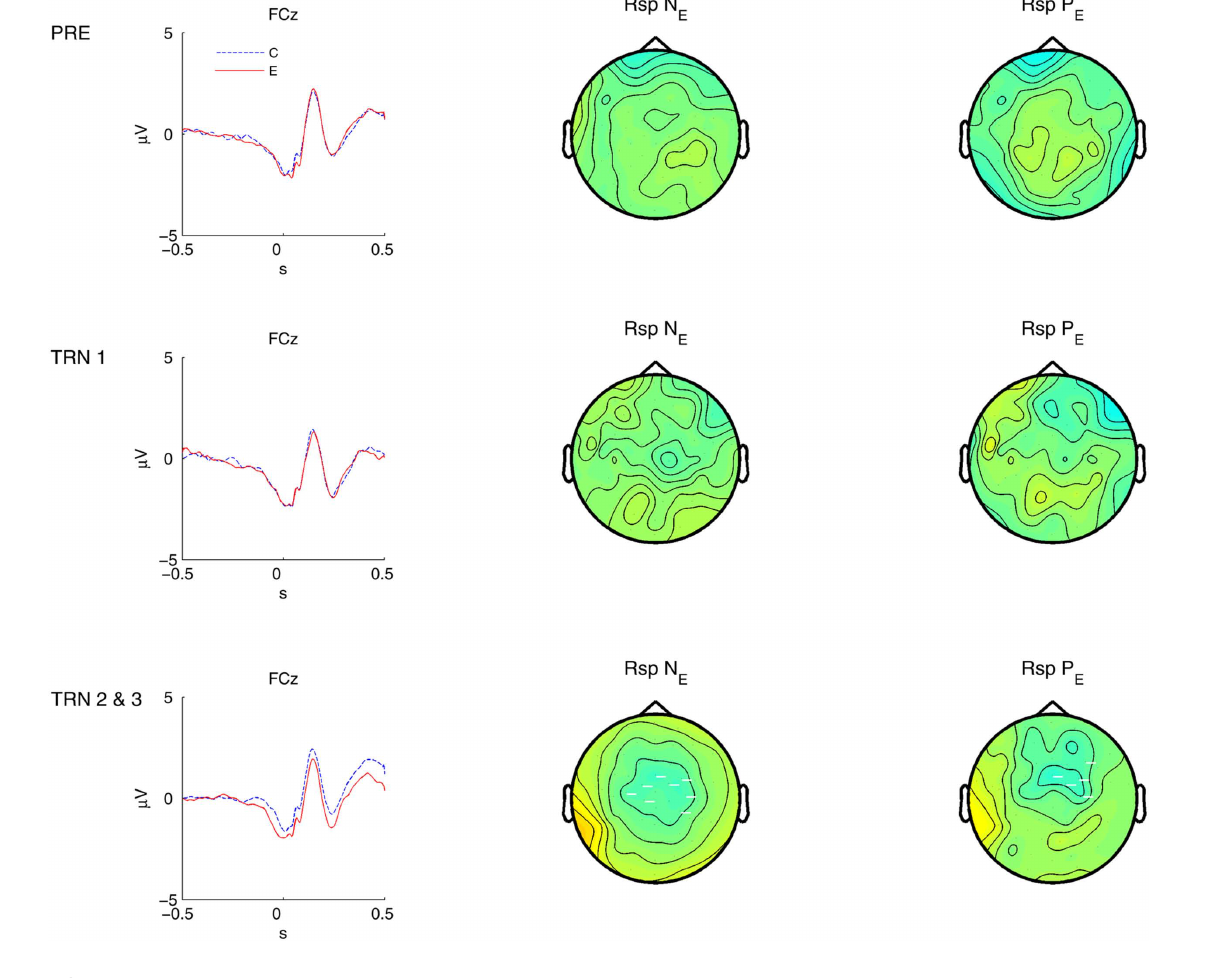
solid line). Symbols plotted on the topographical plots indicate membership within a statistically significant negative cluster (“ − ”) of